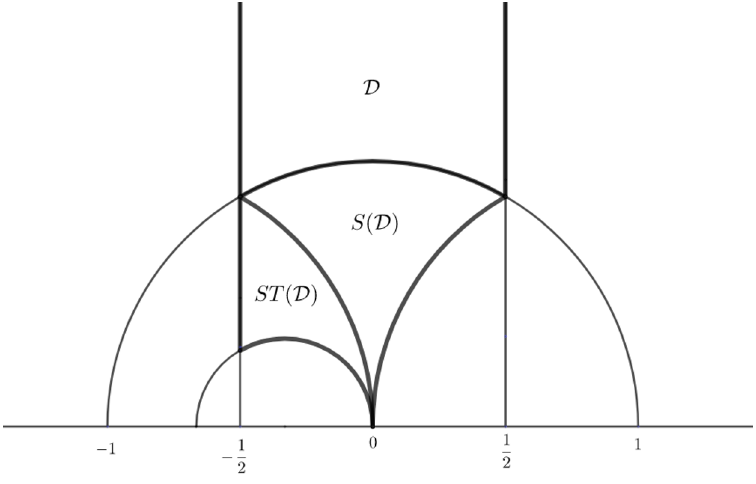
Figure 2. A fundamental domain for (cid:0) 0